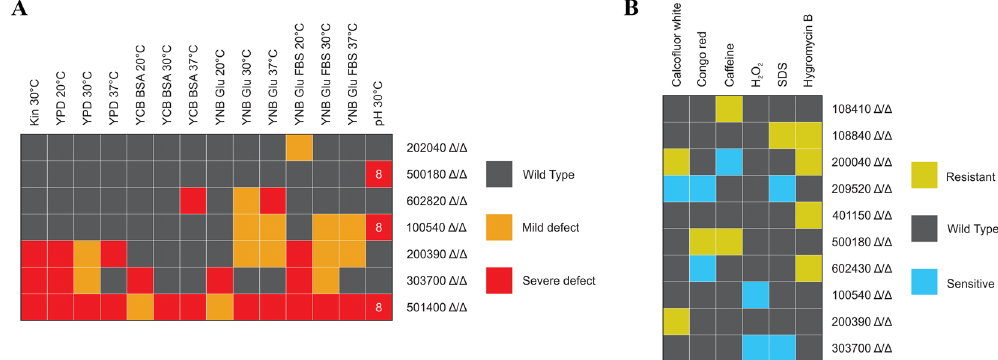
Figure 1. Screening of the C. parapsilosis mutant strains. Summary table of the mutant phenotypes identified through viability testing on different solid media ( A ) and screening of stress responses in stressor supplemented liquid solutions ( B ). Mutant strains with altered phenotypes are shown only. Screening conditions are detailed in the Materials and Methods section and in Supplementary Materials and Methods. Defective growth, sensitive and resistant phenotypes were determined relative to the CLIB 214 wild-type